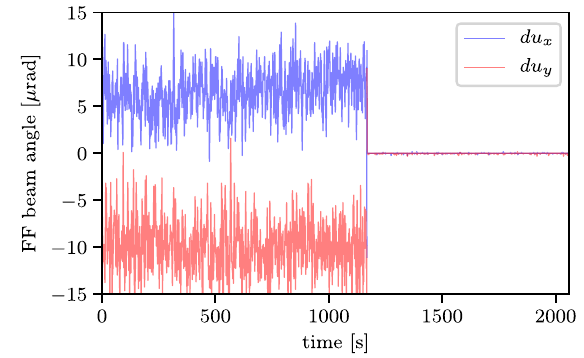
FIG. 15. Residual pointing instabilities recorded with CCD2 at 10 Hz when the fast-pointing stabilization loop is activated on the mount TTPM at t ¼ 1170